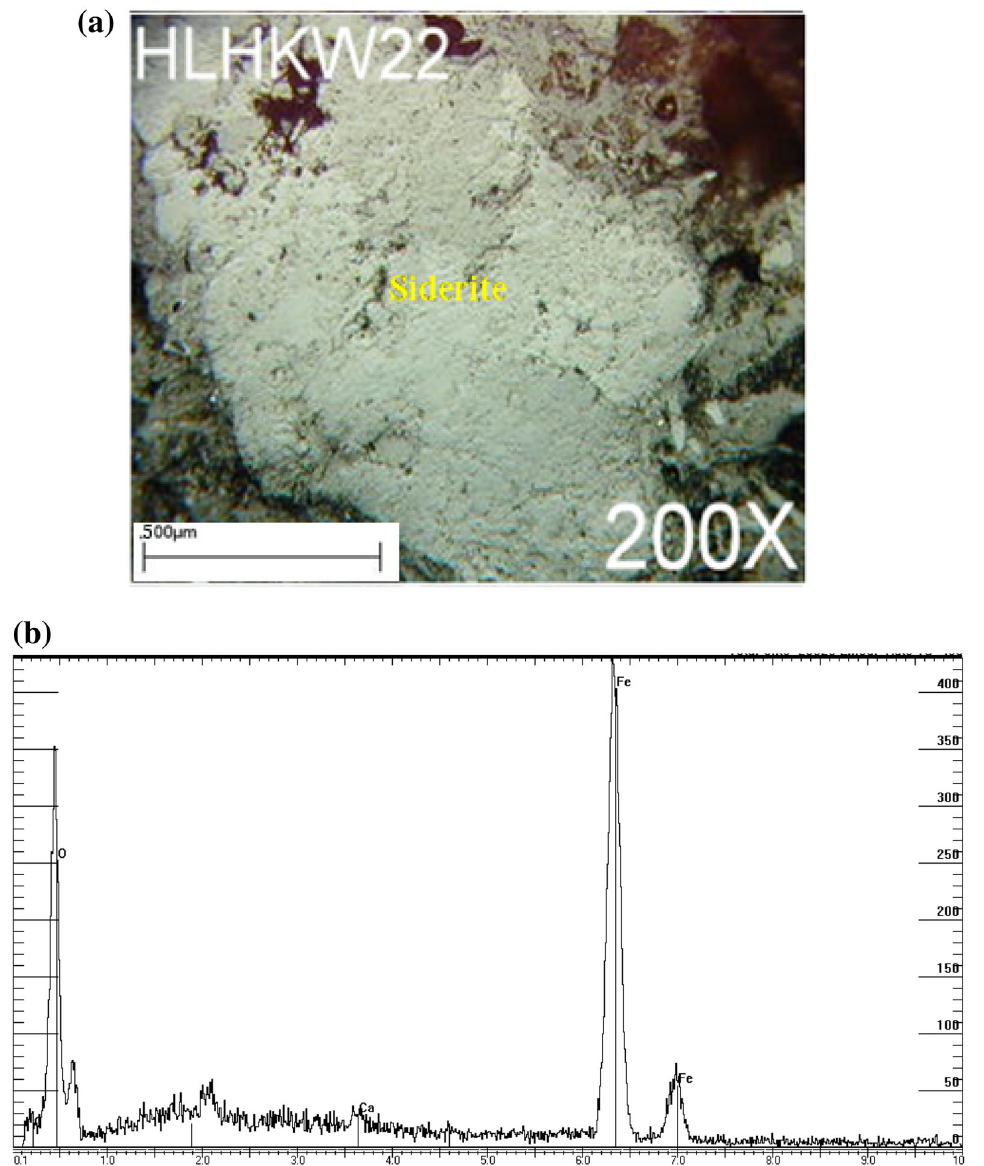
Fig. 3 Siderite in the Huolinhe coal. a Optical microscopy, reflected light; air; polarized light;200 9 . b X-ray energy spectrum diagram scanning area: 100 l m 9 100 l